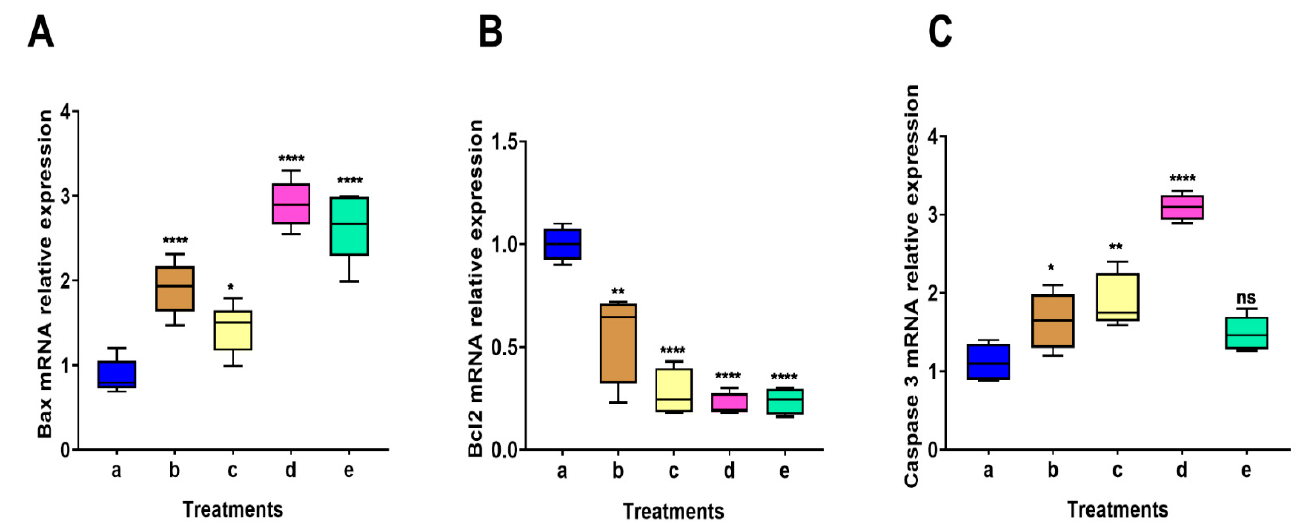
Figure 10. Average qRT-PCR analysis data of the mRNA expression data in different A549 treatments. a: untreated cells; b: PCIBP; c: EPCIBP; d: bevacizumab; e: EPCIBP+ Bev. combination normalized relative to the B-actin endogenous housekeeping gene. ( A ): Bax gene, * p ≤ 0.05, **** p ≤ 0.0001 vs. untreated cells, **** p ≤ 0.0001 vs. untreated cells. ( B ): Bcl-2, ** p ≤ 0.005 **** p ≤ 0.00001 vs. untreated cells. ( C ) Caspase 3, * p ≤ 0.05, ** p ≤ 0.005, **** p ≤ 0.0001, ns: nonsignificant vs. untreated cells.